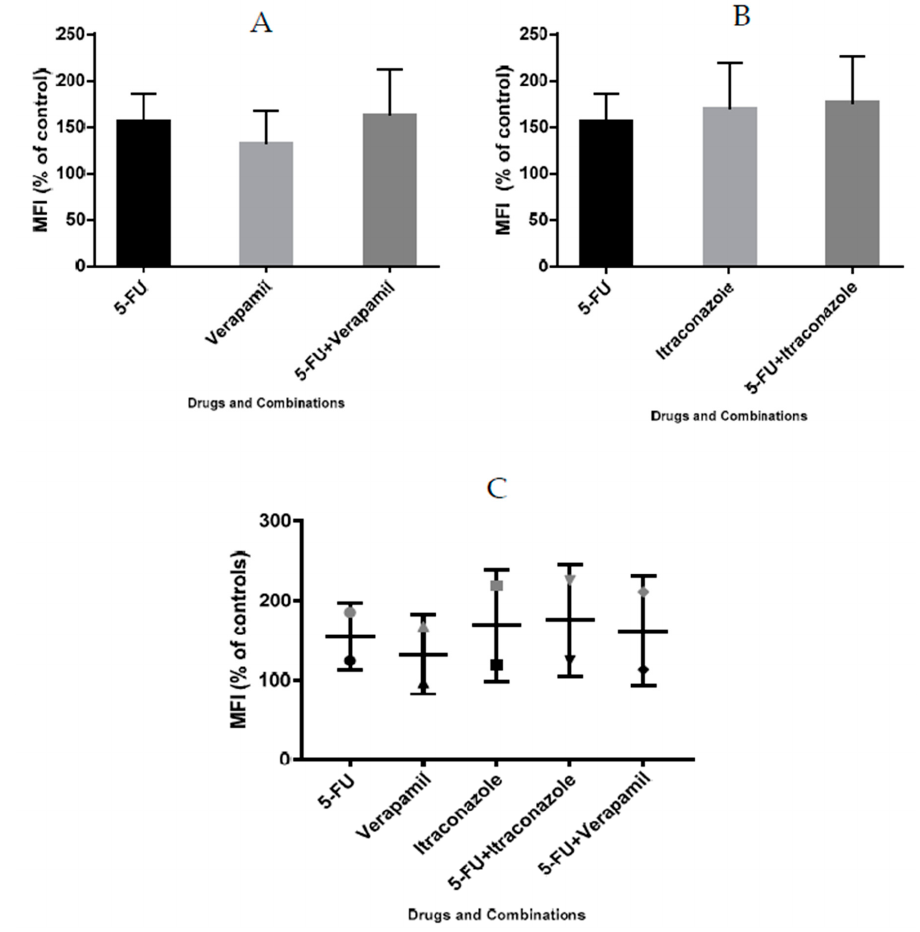
Figure 16. Effect of 5-FU, verapamil ( A ), itraconazole ( B ), and respective combinations of the last two drugs with 5-FU on the proliferation of MCF-7 cells, and a comparison of both experiments ( C ). Each drug and drug combination was added in fresh medium, in duplicates. Results are presented as mean ± SEM, and represent median fluorescence intensity (MFI) (% of control) of 2 independent experiments.